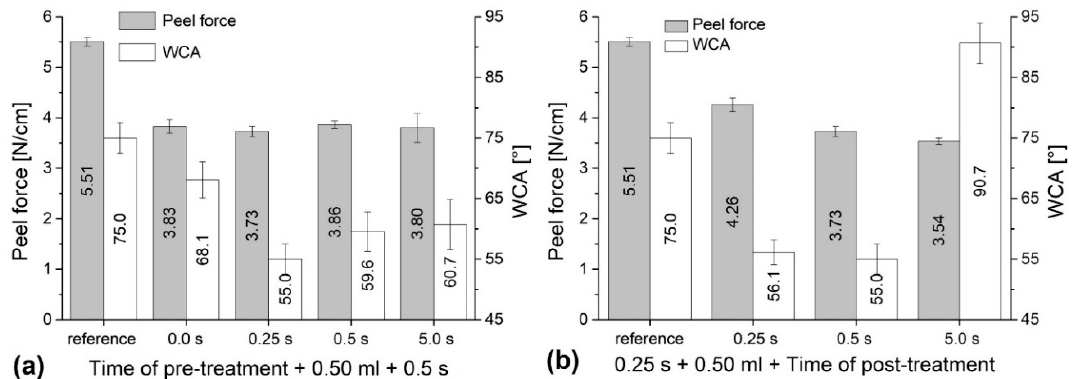
Figure2. Graphsdepictingpeelforceandwatercontactangle(WCA)valuesmeasuredonsilicone-coated Figure 2. Graphs depicting peel force and water contact angle (WCA) values measured on silicone- paper dependent on the air plasma pretreatment ( a ) and post-treatment ( b ) coated paper dependent on the air plasma pretreatment ( a ) and post-treatment ( b ) time.